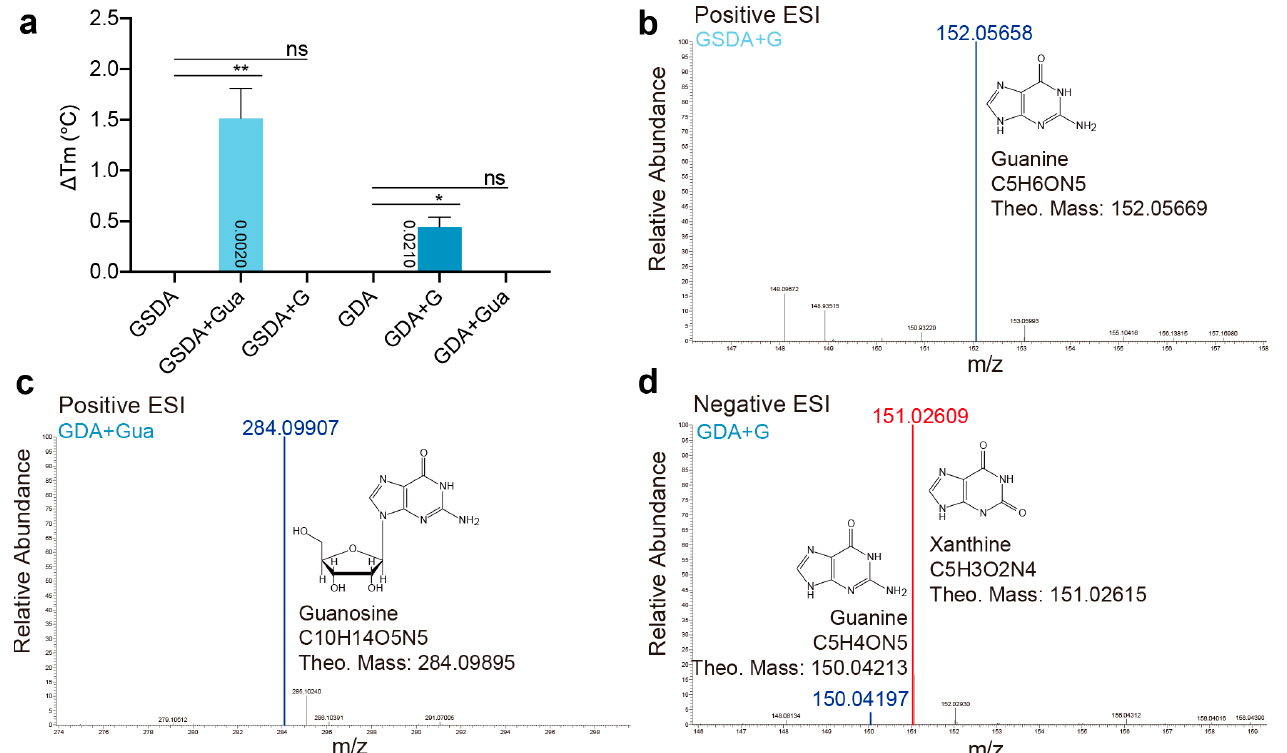
Figure 6. The binding and catalytic specificity of GSDA and GDA. ( a ) The guanosine and guanine binding capabilities of GSDA and GDA. Error bars are s.d. ( n = 3 biological replicates). Statistical evaluation with ANOVA is followed by Tukey’s post test. Probability values for pairwise comparisons to the group of apo-protein respectively, are shown at the respective bars. *: p < 0.05, **: p < 0.01. ns: no significance. ( b ) The 24-h deamination reaction of AtGSDA with guanine. ( c ) The 24-h deamination reactions of GDA with guanosine. ( d ) The 2-h deamination reactions of GDA with guanine. The blue and red lines indicate the substrates and the products, respectively.